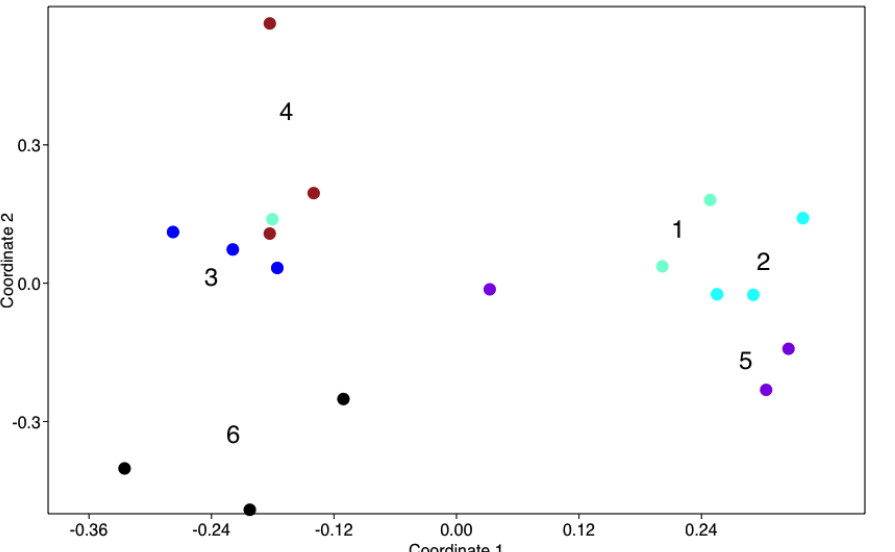
Fig. 4. PCoA plot of L. peltata populations studied based on anatomical features (Populations 1-6 are according to Table